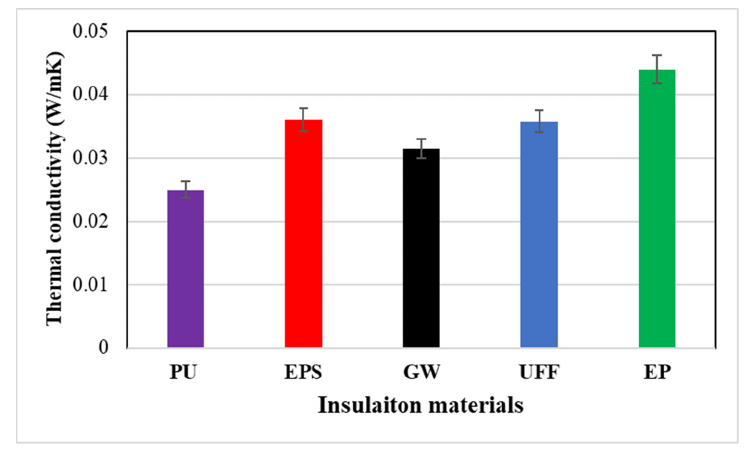
Figure 4. Thermal characteristics of various insulation samples.